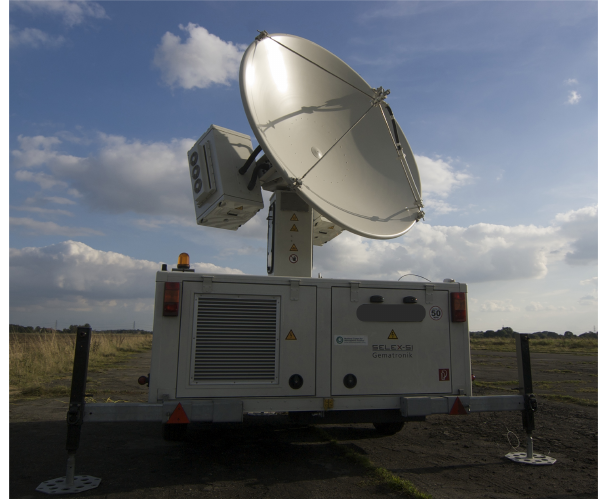
Figure 1. Photograph of the NXPol collecting data at Burn Airfield near Selby, UK. Here the NXPol is deployed using only its trailer as a